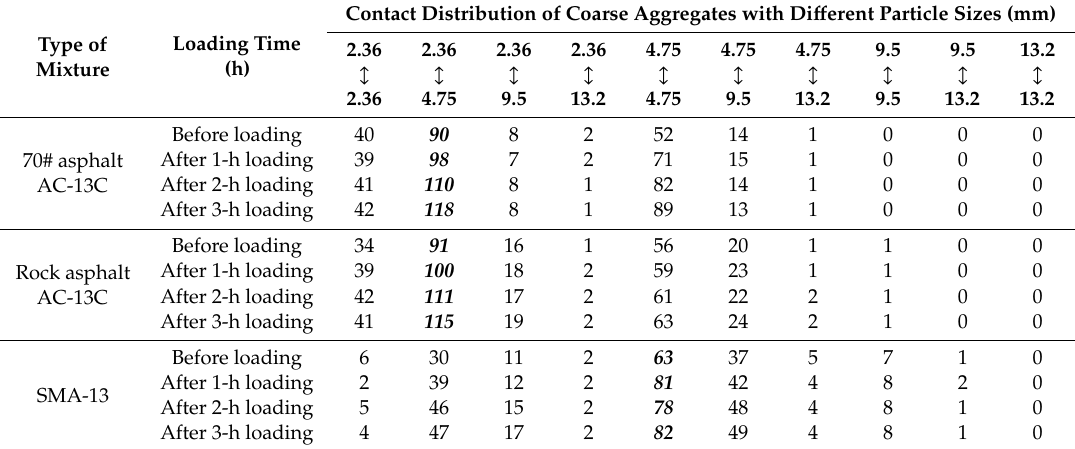
The rutting resistance of asphalt mixtures is closely related to the size of coarse aggregates constituting the main skeleton. The contribution of coarse aggregates with different particle sizes to the contact points is an important factor for determining the stability of the main skeleton. The contact analysis is performed using iPas software; the coordination number of each coarse aggregate can be obtained by statistical analysis after determining the number and particle size information of each coarse aggregate. The contact distribution statistics of coarse aggregates with different sizes at different loading stages are summarised in Table 8, in which the bold italic numbers indicate the peak value positions. In this table, 2.36 mm ↔ 2.36 mm indicates that the coarse aggregates with particle sizes of 2.36–4.75 mm come into contact with 2.36–4.75 mm coarse aggregates; 2.36 mm ↔ 4.75 mm indicates that the coarse aggregates with particle sizes of 2.36–4.75 mm come into contact with 4.75–9.5 mm coarse aggregates; the rest may be deduced by analogy. Table 8. Contact distribution of coarse aggregates at different loading stages.